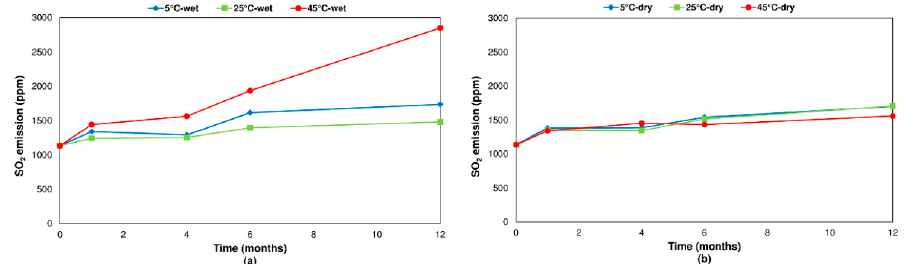
Figure 5. Sulfur dioxide emission area of the chalcopyrite composition at 600–900 ° C in ( a ) a wet environment and ( b ) a dry environment .